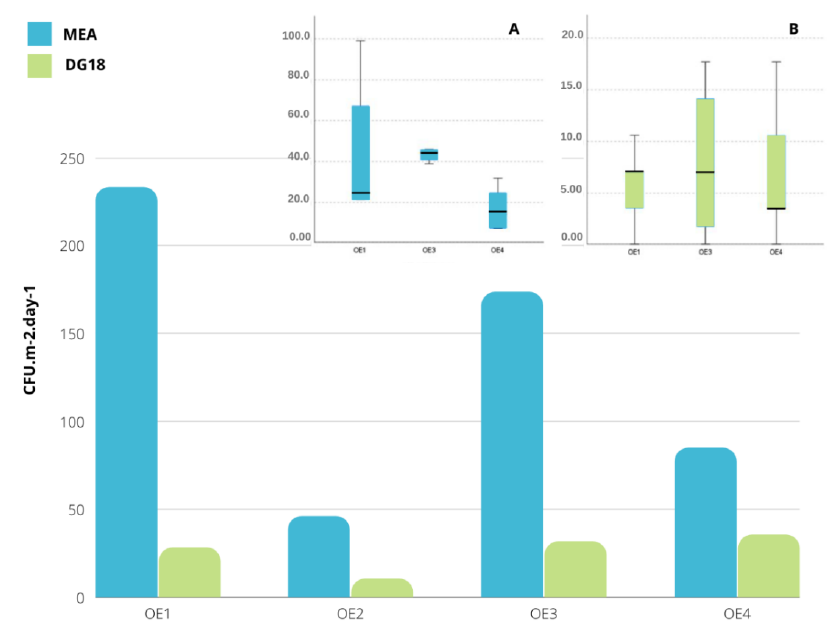
Figure 4. Total fungal counts on MEA and DG18 in samples from different areas (CFU · m − 2 · day − 1 ). Boxplot for comparison of fungal contamination in MEA ( A ) and DG18 ( B ) media between sampled areas (excluding the sculpture area (OE2), since it has a single record).